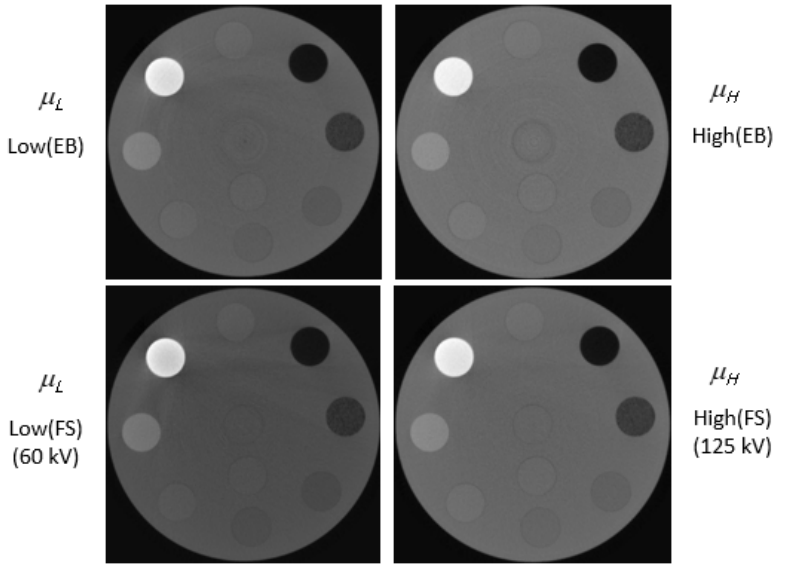
Figure 3. Dual ‐ energy CT images shown with linear attenuation coefficients acquired in energy bin (EB) and full spectrum (FS) modes.